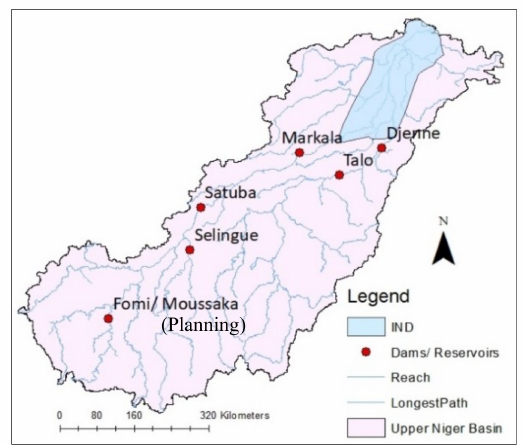
Figure 2. Hydrodynamic model domain, along with dams and reservoirs in the Upper Niger